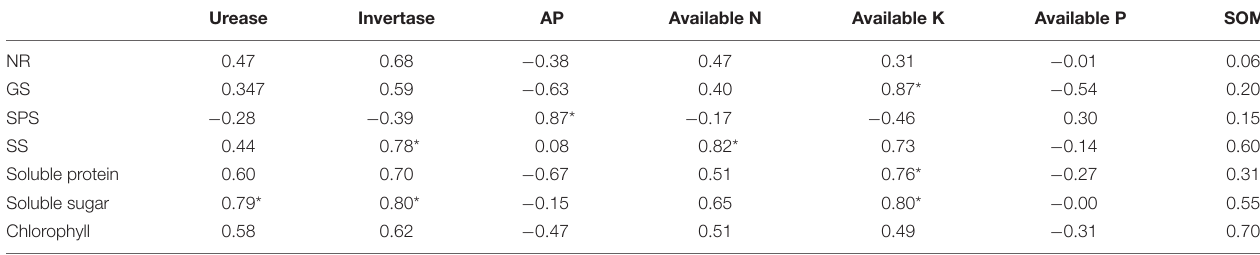
TABLE 5 | Pearson’s correlation coefficients between soil properties and leaf physiological attributes. Urease Invertase AP Available N Available K Available P